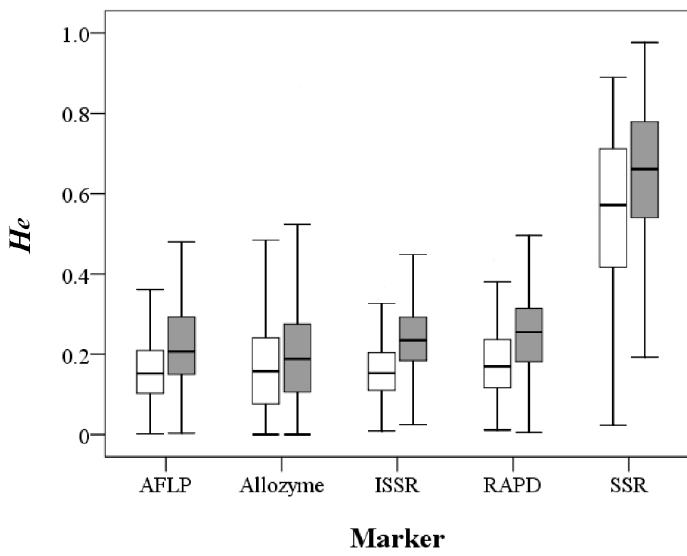
Figure 1. Distribution of the expected heterozygosity values at the population (open box) and species (filled box) levels derived by the five molecular